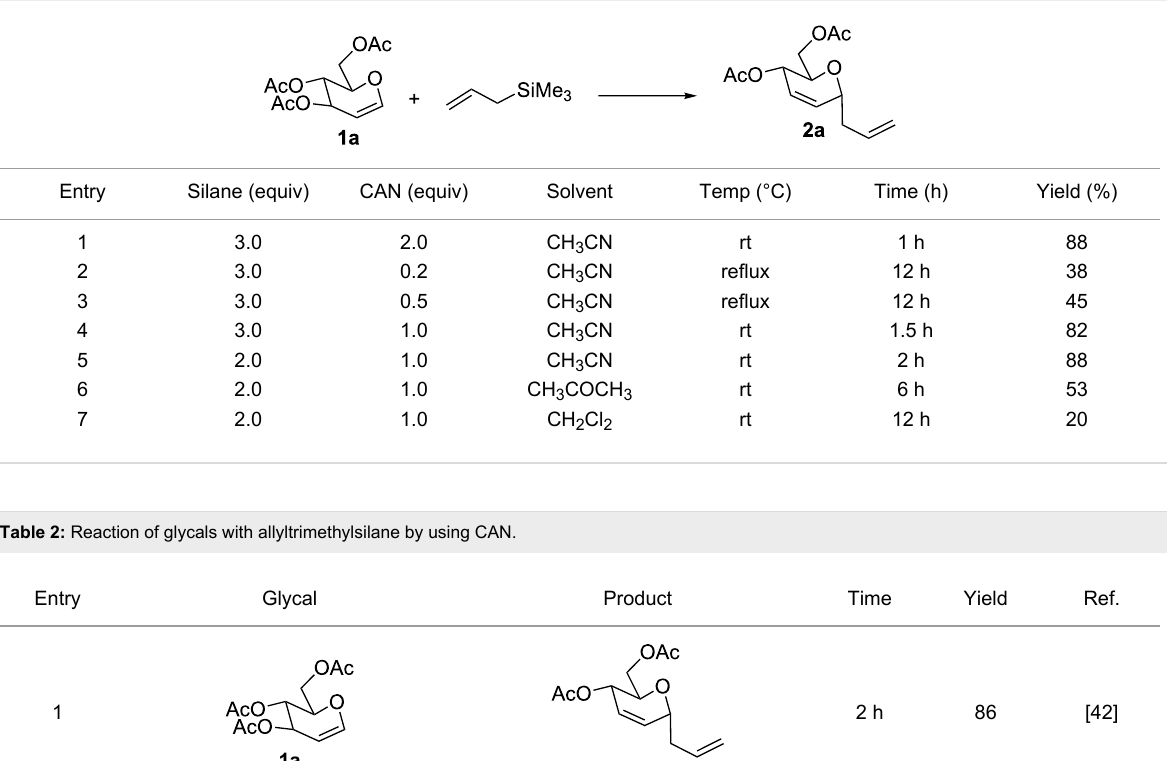
Table 1: Optimization of reaction conditions.